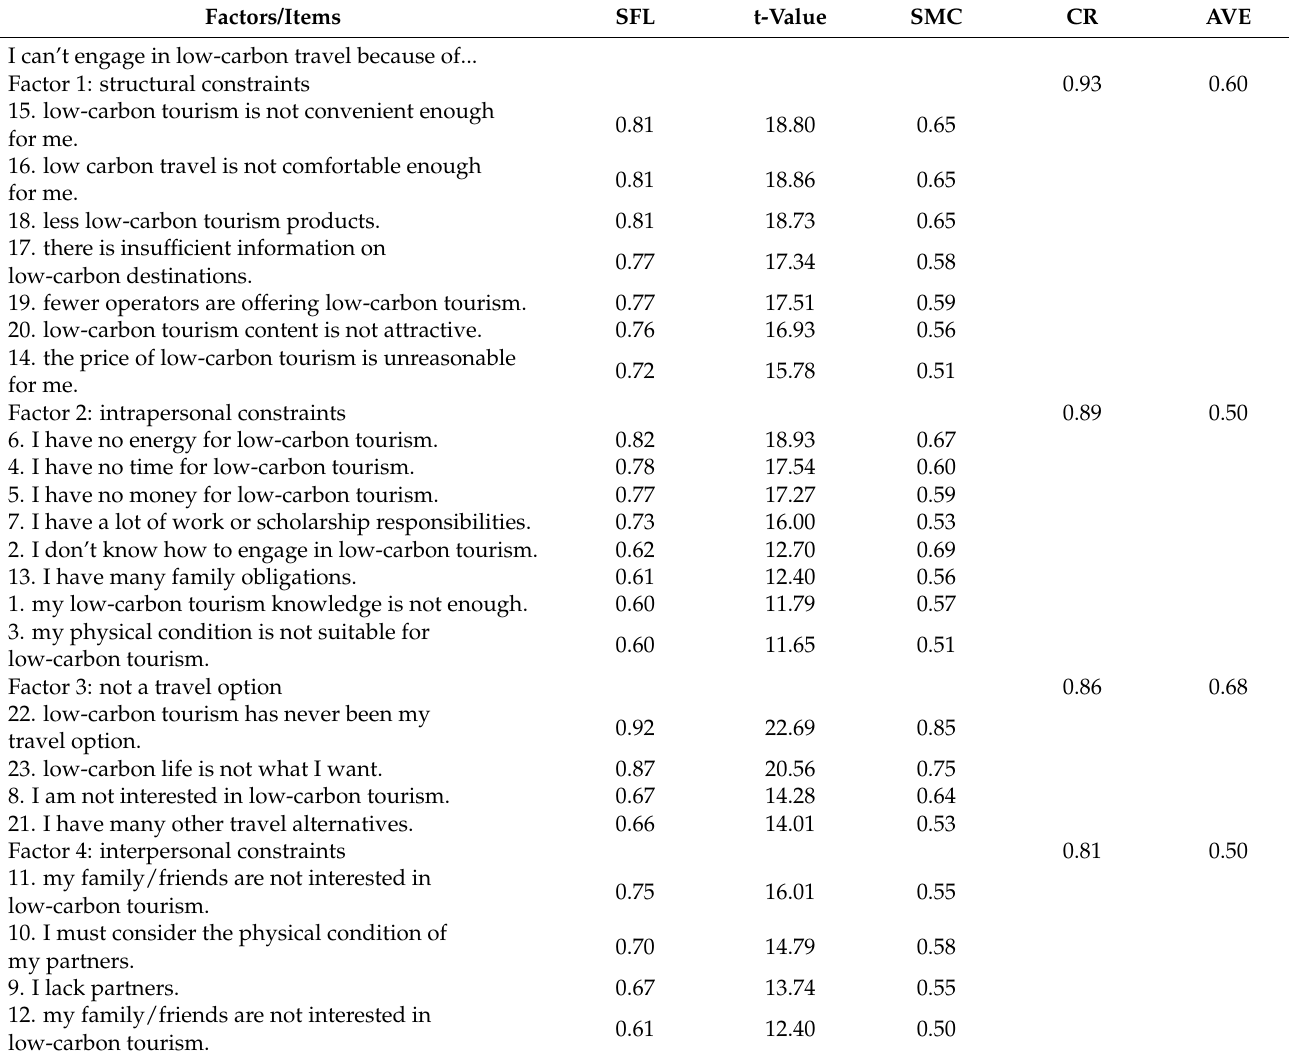
Table 6. CFA results of LCTCS—sample from non-low-carbon destinations ( n = 390). Factors/Items